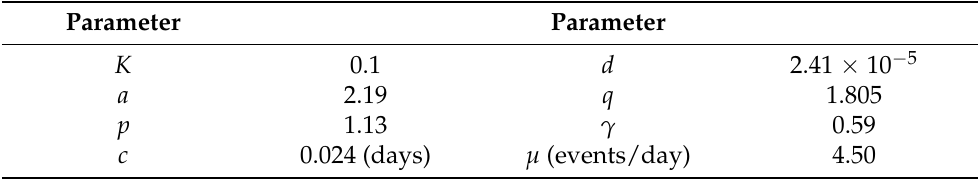
Table 1. ETAS parameters used for the synthetic earthquake catalog with m c = 2.5. The target area is Corinth Gulf, Greece, with Σ x [ t in , T ] = [ 21.3 ◦ E − 23.2 ◦ E ] × [ 37.9 ◦ N − 38.6 ◦ N ] × [ 2,20 ] . The number of clustered events is N = 4253 and the number of mother events is N bg =